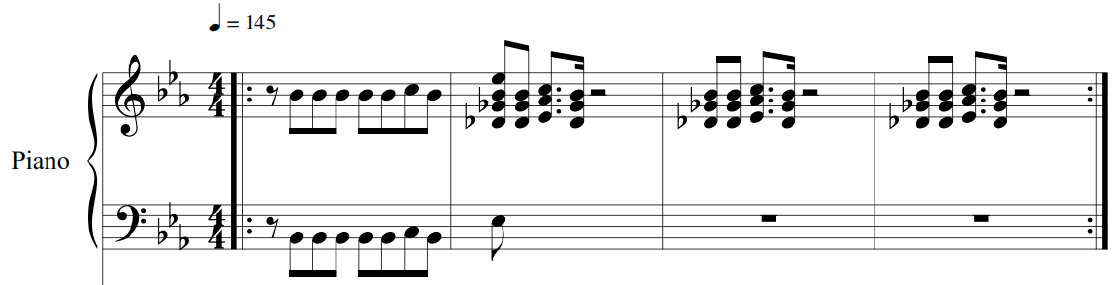
Figure 2. Excerpt from shouting music at Greater Harvest Missionary Baptist Church (MBC).